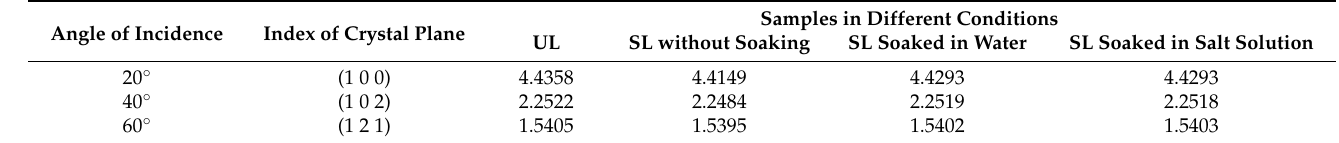
Table 9. The mineral crystal plane spacing of UL and